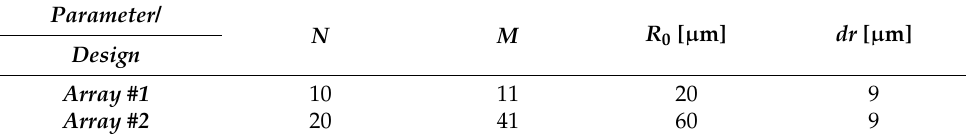
Table 1. Design parameters of optical phased arrays with circular geometry.